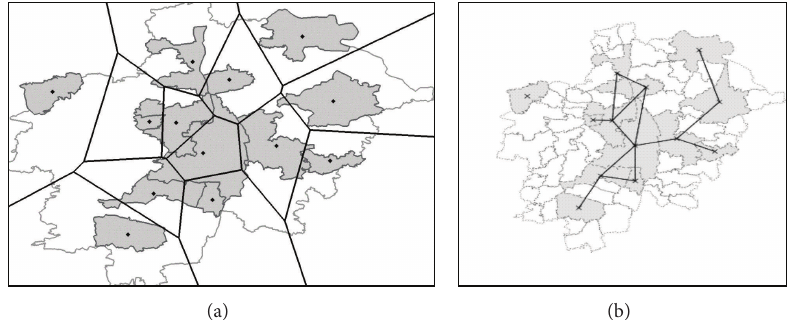
Figure 2: (a) Regionalization of the study area in 13 Thiessen polygons; each polygon represents a LU. LU centroids were used to delimit the Thiessen polygons; (b) net of contiguous LUs; three LUs were spatially connected to the next sampled LU performing a geometrical correction of LUs’ boundaries: Schwabm¨unchen was connected to Bobingen, Aichach to Friedberg, and P¨ottmes to Aichach; vectors show pairs of LU assigned a spatial weight equal to unity in the matrix of spatial weights; pairs of LUs not connected with vectors received a value equal to zero in this